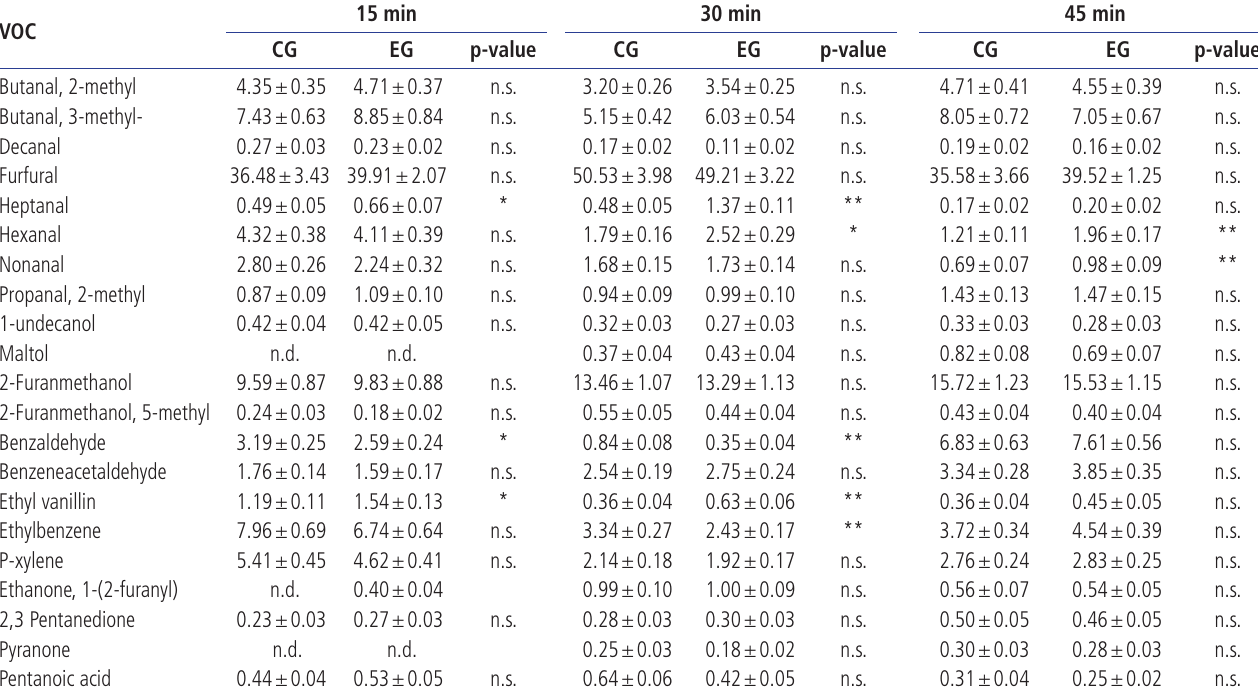
Table 7. Volatile compounds detected in cupcakes subjected to different cooking times (15, 30, and 45 min) and prepared by using eggs obtained from control and experimental group